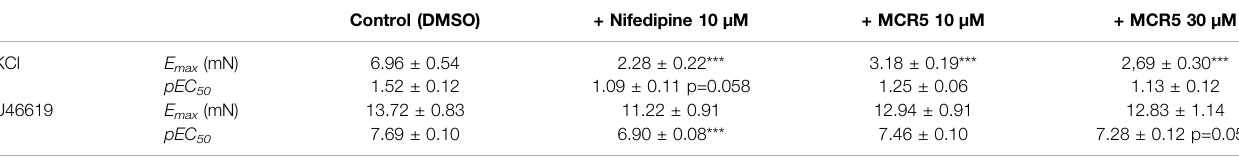
TABLE 1 | Maximum response ( E max ) and potency ( pEC 50 ) of the concentration – response curves to KCL ( n = 4) and U46619 ( n = 4) contractions (mN) in aortic rings from young OF1 mice.